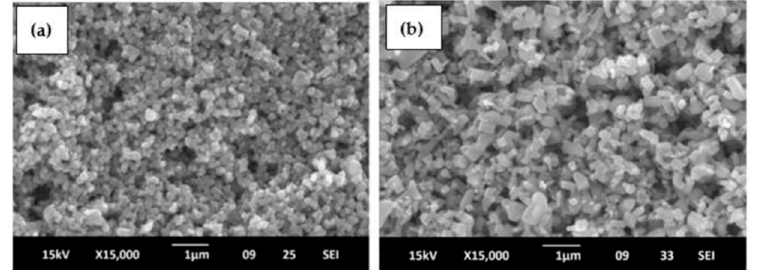
Figure 20. SEM showing TiO (cid:2870) ( a ) and ZnO ( b ) morphologies [96]. Reprinted from an open-access